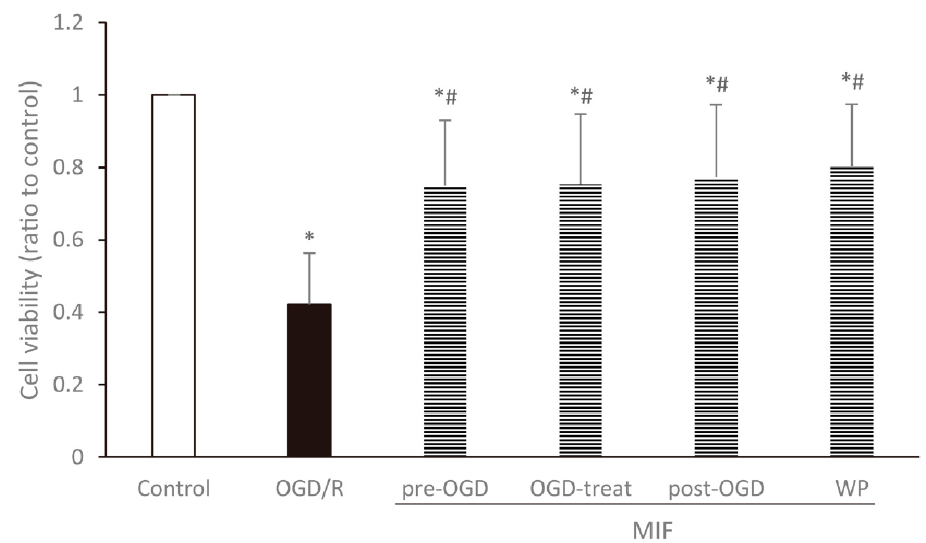
Figure 5. Cell viability assessed using the WST-1 assay relative to the control group. Cell viability significantly increased in the MIF groups compared with the OGD/R group. Mean ± SD values from 30 independent experiments are presented. * p < 0.05 vs. control; # p < 0.05 vs. OGD/R group. The differences among the groups were analyzed using one-way ANOVA followed by Tukey’s post hoc